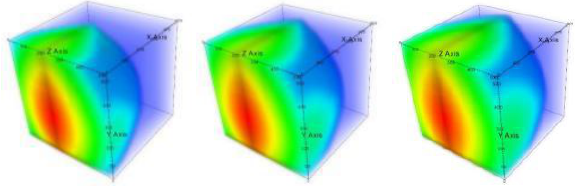
Figure 4.Simulation of experiment 1 (every 10 iterations)